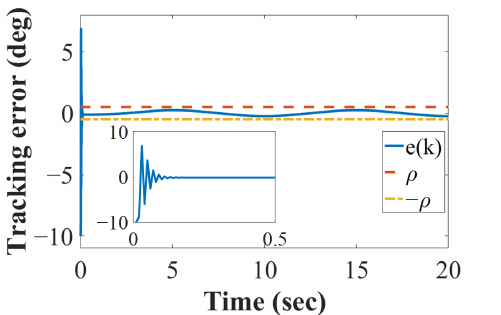
Figure 10. Tracking errors of the simulation in group 2 (proposed